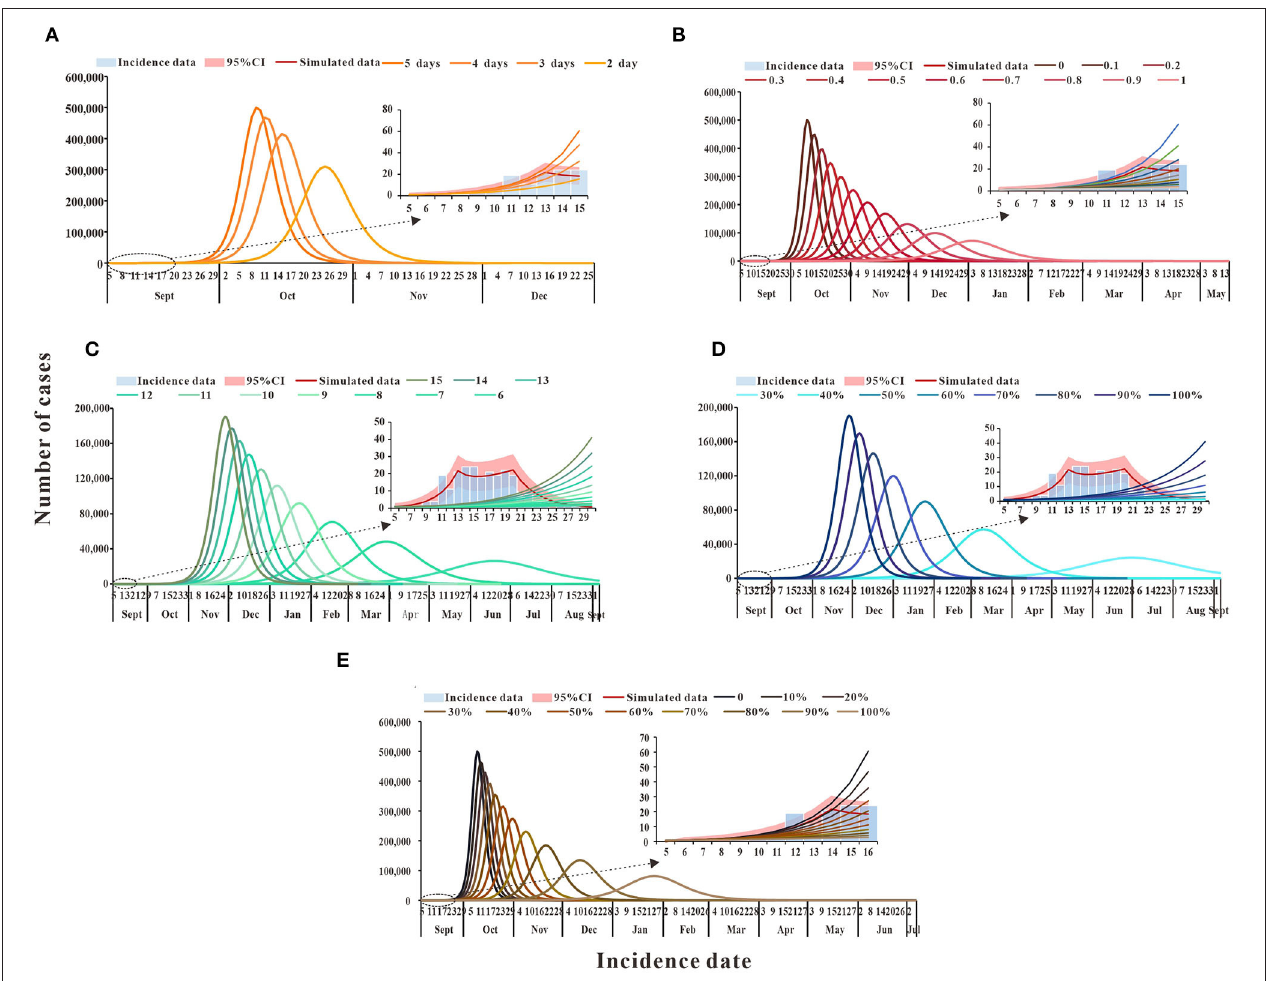
FIGURE 4 | The simulation results of single intervention measures in Xiamen City, China, 2021. (A) Medical treatment; (B) isolation; (C) social distancing; (D) wearing masks; and (E) vaccination.